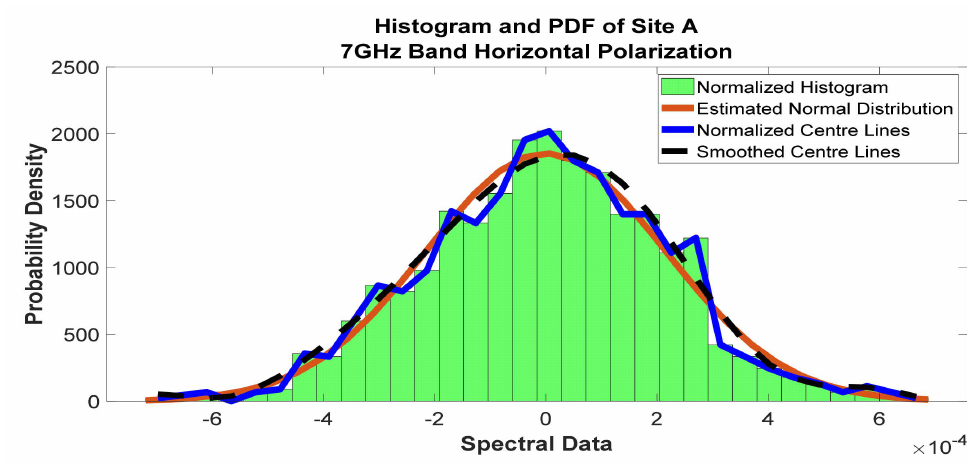
Figure 19. Histogram and PDF of the frequency scan for site A at 7 GHz horizontal polarization.